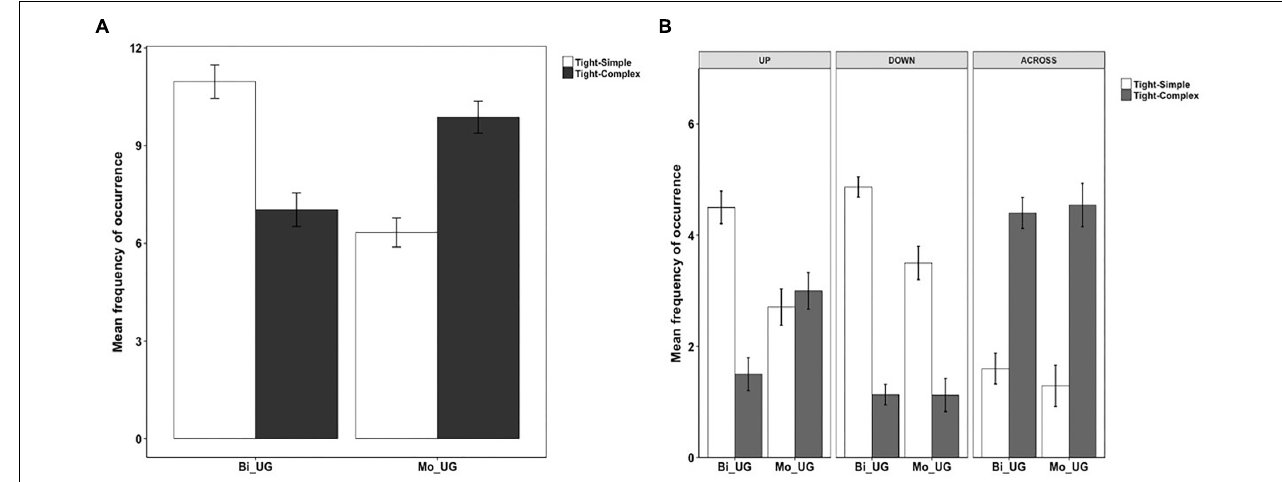
FIGURE 7 | Syntactic packaging in Uyghur.